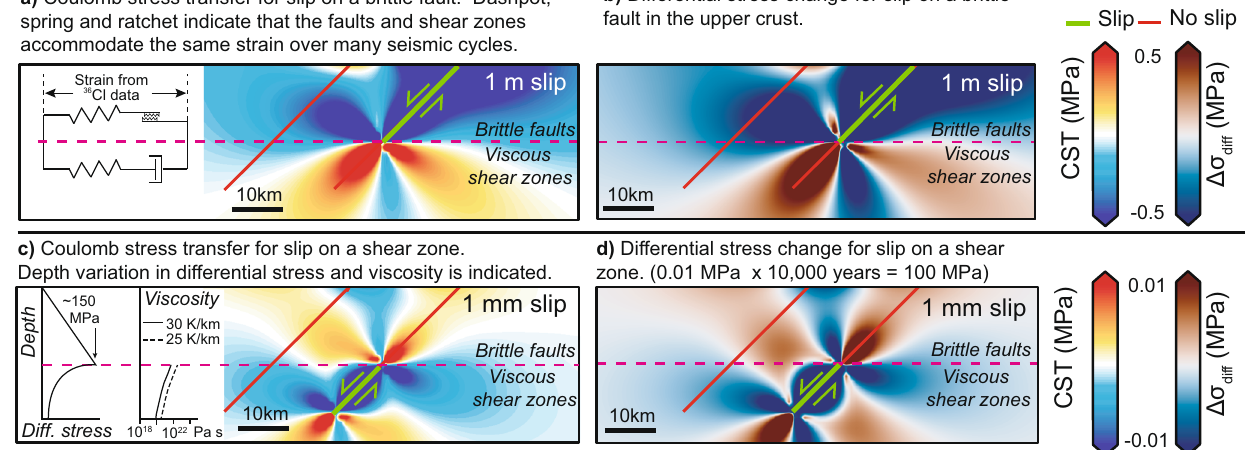
that the part of the shear zone that is most resistant to deformation (i.e., rate- limiting) will be the shallowest part due to the highest viscosity. d shows the differential stress resulting from slip on a viscous shear zone. Both earthquakes andshearzoneslip transfernegative differentialstress(areductioninstress)onto theneighboringshearzone,soachangeinstrain-rateonthereceivershearzoneis implied.